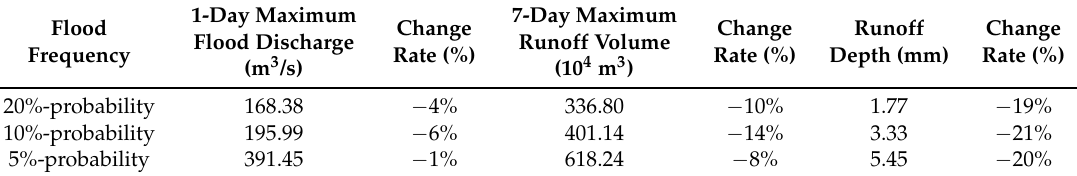
Table 9. The results of three indictors of S2.